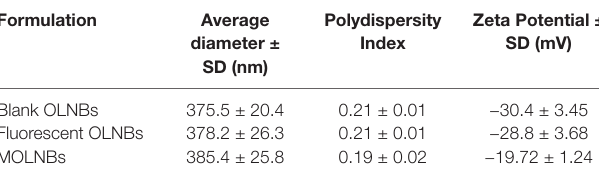
TABLE 1 | Physicochemical characteristics of NB